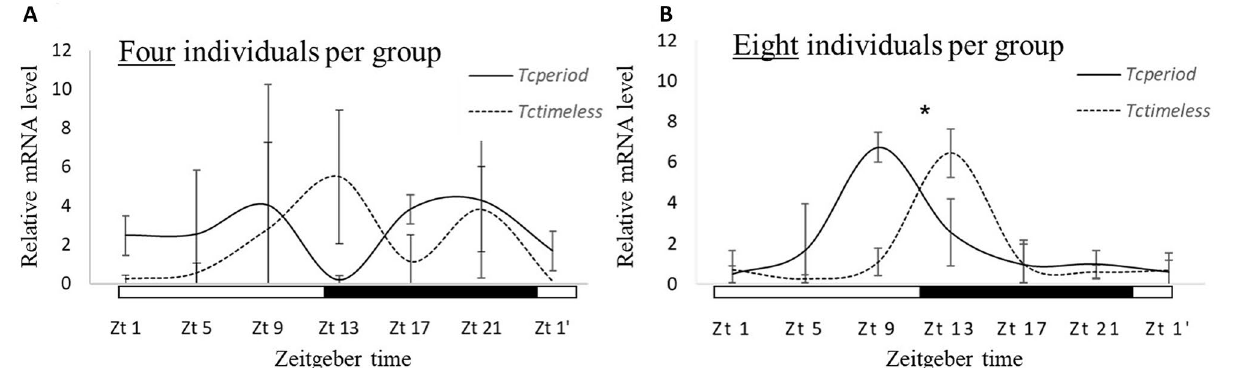
Figure 1. Tctim and Tcper expression (mean ± SD) in groups of four ( A ) and eight ( B ) individuals. The expression of Tctim and Tcper peaks only in individuals originating from the group of eight ( B ). White and black bars indicate light phase and night, respectively. *indicates the peak of gene expression with a significant